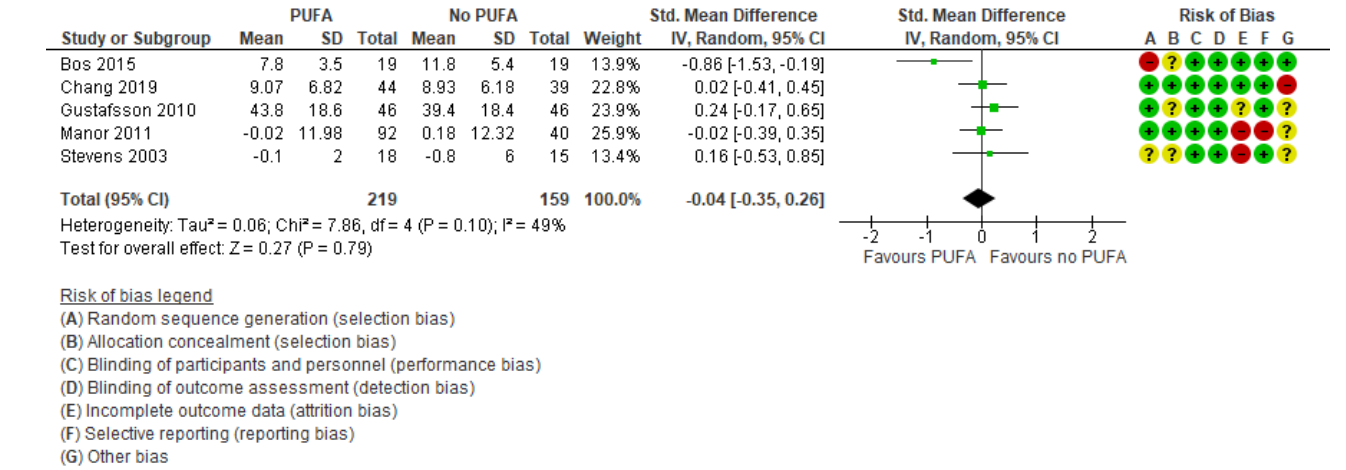
Figure 5. Forest plot of comparison: PUFA vs. placebo, outcome: parent-reported behavioral difficulties (end of treatment). Green square indicates summary estimates of the individual studies. Black diamond indicates total summary effect esti- mate.